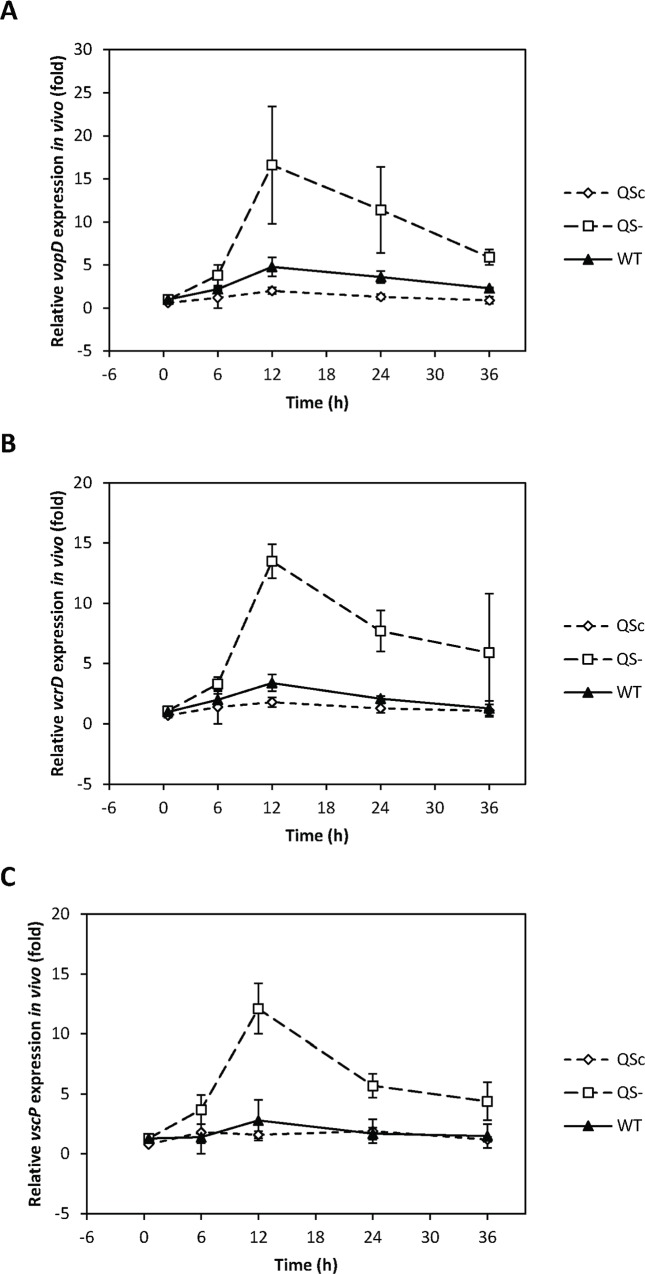
In vivo expression of the type III secretion system genes vopD, vcrD and vscP.
In vivo expression of the type III secretion system genes vopD
(A), vcrD
(B) and vscP
(C) in wild type V. harveyi (WT) and mutants with the quorum sensing system locked in high cell density configuration (QSc) and the quorum sensing system locked in low cell density configuration (QS-), respectively, during infection of brine shrimp larvae. The expression in wild type V. harveyi at the 0.5h time point was set at 1 and the expression in all strains at all time points was normalised accordingly using the 2-ΔΔCT method. The error bars represent the standard deviation of three independent shrimp cultures (each time based on bacterial mRNAs extracted from 500 larvae). The RNA polymerase A subunit (rpoA) mRNA was used to normalise between strains.